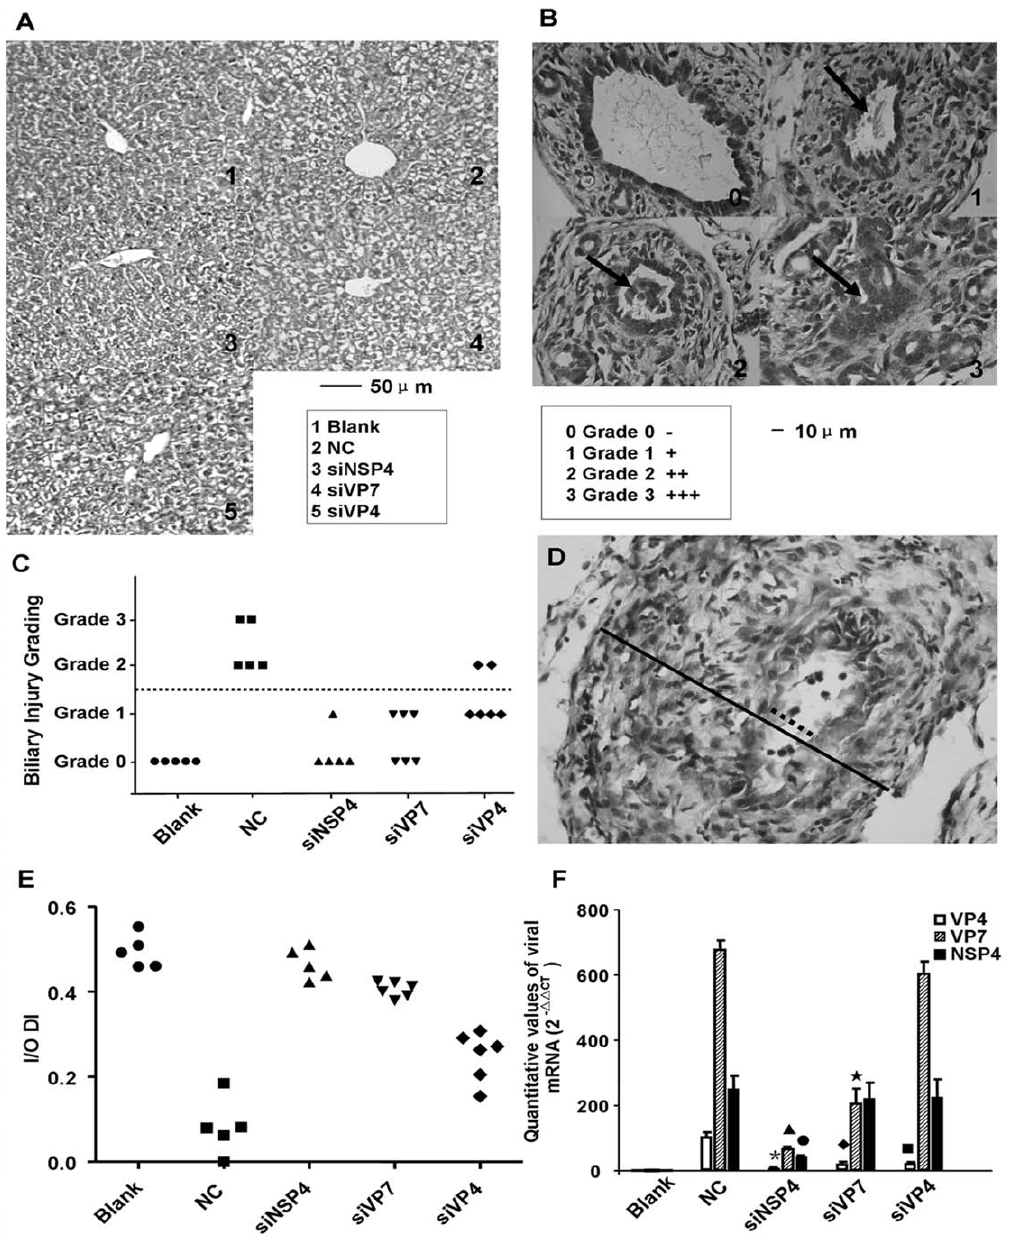
Figure 3. Hepatobiliary injury, incidence of biliary atresia and intraluminal rotavirus replication in the bile ducts. (A) Hematoxylin and eosin staining of livers. Ballooning degeneration and mononuclear cell infiltration were the basic pathologic changes in the liver of rotavirus infected mice in the NC group, but none suffered from hepatic cirrhosis. siNSP4 and siVP4 transfection decreased hepatic injury, but siVP7 transfected mice still suffered from significant hepatic injury. (B) Grading of extrahepatic bile duct injury. Grade 0: No obstruction, stenosis, necrotic epithelia or inflammatory cell infiltration. Grade 1: Mild stenosis and several inflammatory cells. Grade 2: Stenosis or obstruction caused by necrotic cells or inflammatory cells in bile duct lumens. Grade 3: Complete lumen obstruction. Black arrow pointed at the site of injury. (C) Summary of distribution of biliary injury grading. Biliary injury was significantly inhibited by siNSP4 (0/5), ( P , 0.05) compared to NC (5/5). Three of siVP7 transfected mice suffered mild biliary injury. Half of siVP4 transfected mice suffered BA. (D) Measurement of inner and outer diameters of bile ducts. The dashed line and black line respectively indicated the inner and outer diameters. (E) Summary of distribution of inner/outer diameter index (I/O DI). siRNA transfected mice had relatively higher index value (all P , 0.05, compared to NC). siNSP4 had the highest I/O DI which was not significantly different from the blank controls ( P . 0.05). (F) Quantitative analysis of viral messenger RNA (mRNA) in bile ducts on 7 dpi using real-time reverse transcription polymerase chain reaction. siNSP4 decreased the level of all viral mRNAs ( * m N P , 0.05, compared to NC). siVP7 inhibited the transcription of VP7 and VP4 mRNAs ( ¤ w P , 0.05, compared to NC). siVP4 only inhibited the mRNA expression of VP4 ( & P , 0.05, compared to NC).